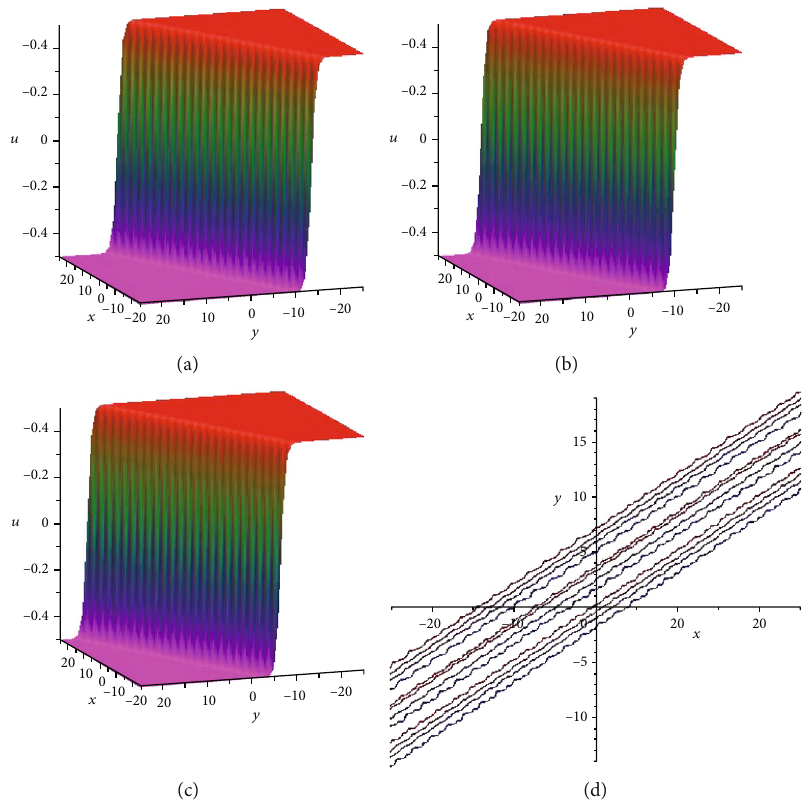
Figure 2: Evolution of Equation (62) at (a) t = 10 − 1 , (b) t = 10 2 , and (c) t = 10 5 . (d) Contour plot.